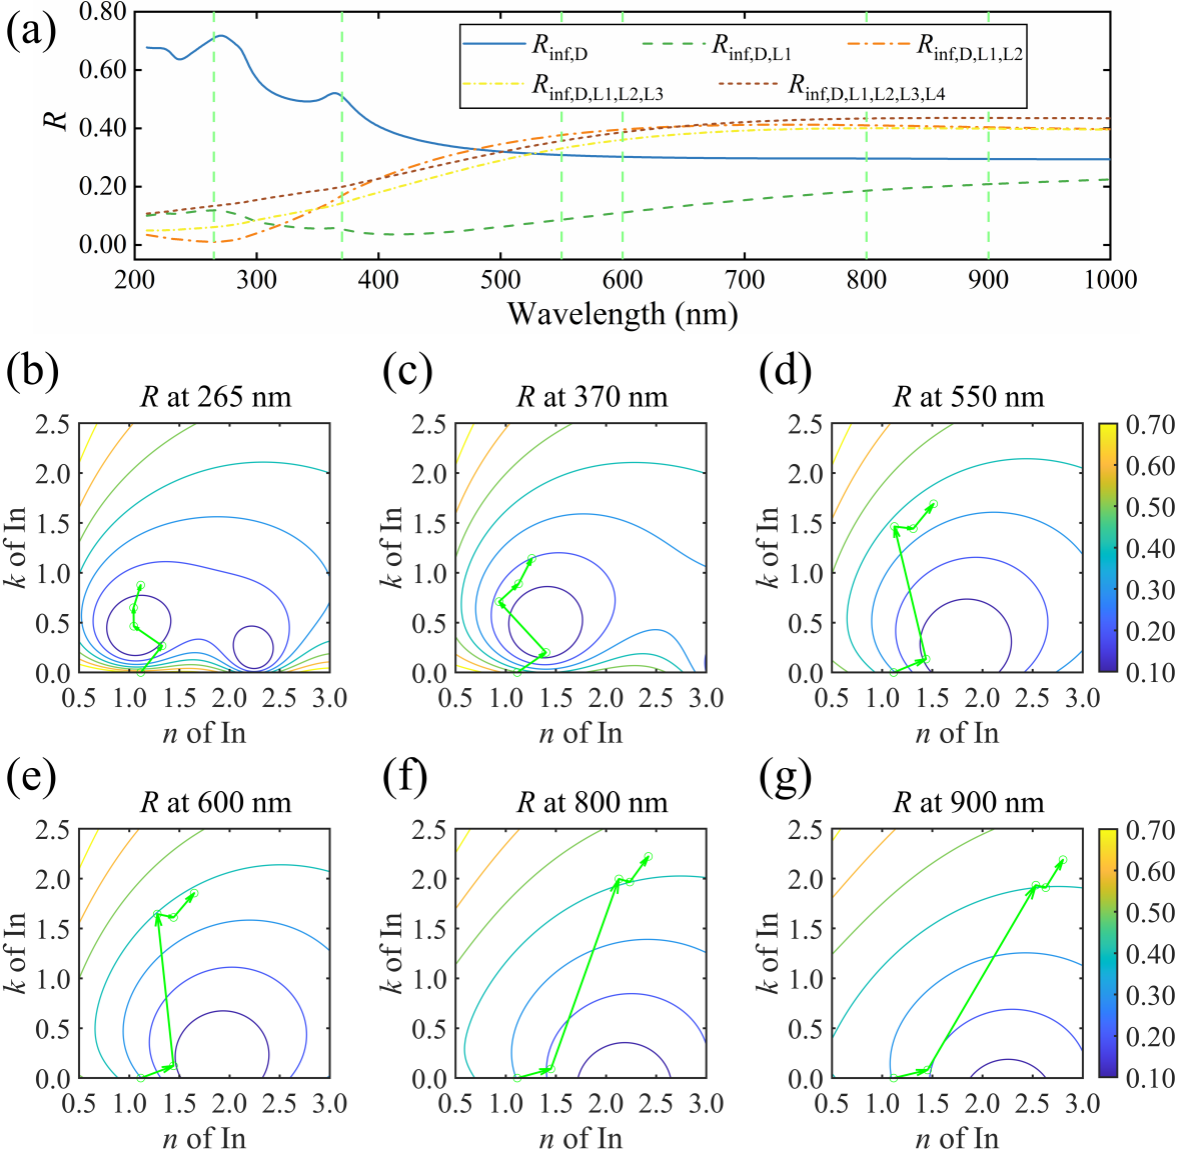
Figure 5. Reflectance spectra with different Lorentz oscillator components for ( a ) S4 and the oscillator decomposition at a wavelength of ( b ) 265, ( c ) 370, ( d ) 550, ( e ) 600, ( f ) 800 and ( g ) 900 nm. Curves in ( b – g ) are the contour lines of reflectance.